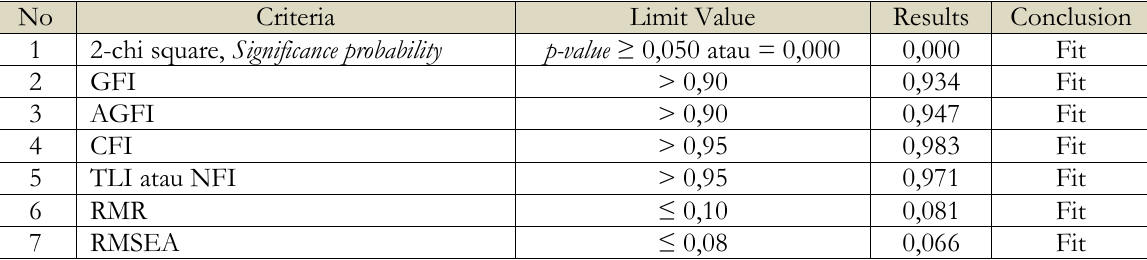
Goodness of Fit (GOF) Results in the Final Model